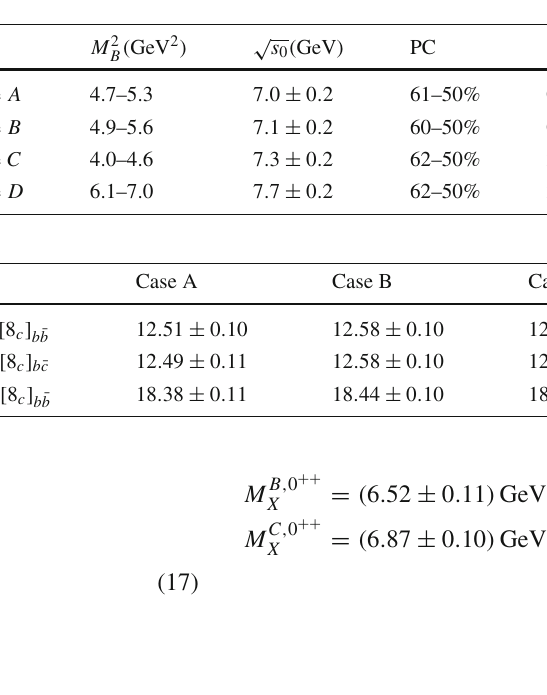
with J PC = 0 ++ and different values of B